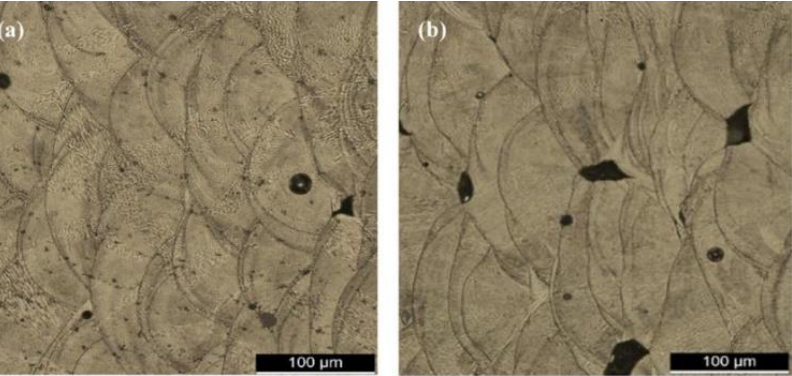
Figure 7. Microstructure showing the presence of porosity in stainless steel samples fabricated by the SLM process as a function of different laser scanning speeds: ( a ) 200 mm/s and ( b ) 400 mm/s [114].